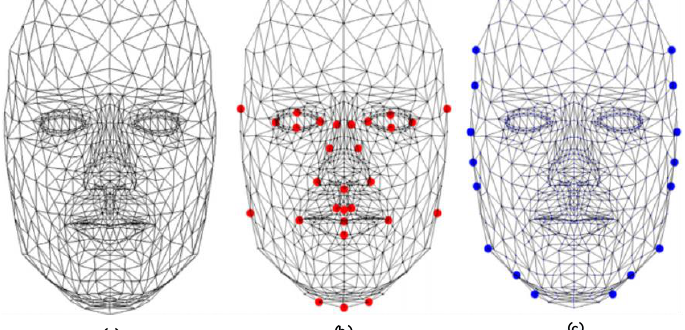
Figure 6. ( a ) Creation of the 3D face of a person, ( b ) results of the detection of 29 landmarks of a face using the active shape model, ( c ) results of the detection of 26 landmarks of a face [3] .